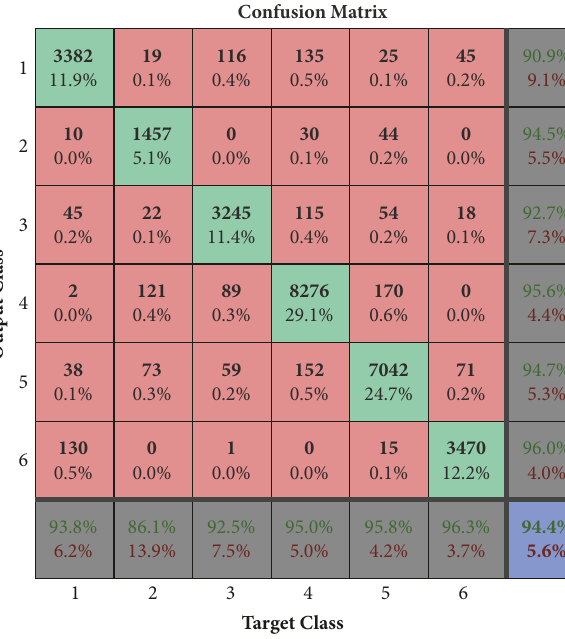
Figure 16: Regression 𝑅 .